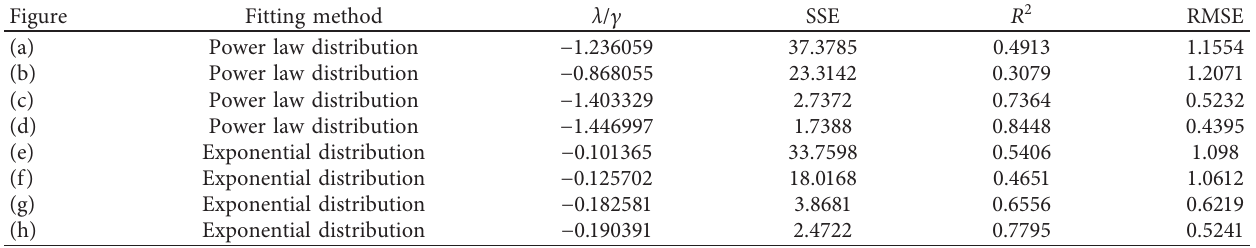
Table 1: Statistics of goodness of fit